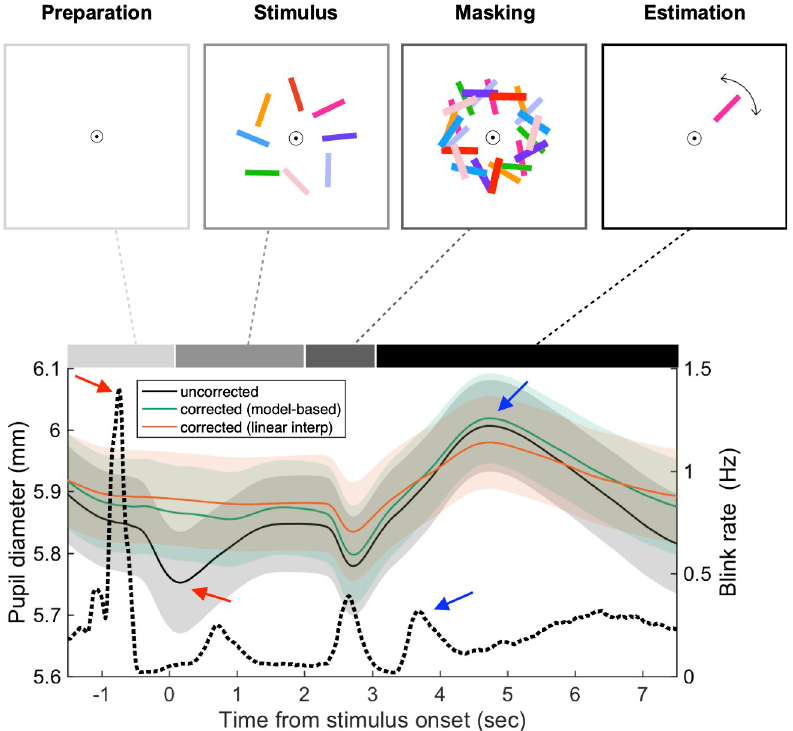
Fig 8. Temporal bias in blink patterns induces spurious distortion of pupil time course in the delayed orientation estimation task. Pupil (solid line) and blink rate (dotted line) time course during the delayed orientation estimation task. Since BPR induces pupillary constriction, the pupil-size time courses corrected by the model-based method (green) and the linear interpolation method (orange) were larger than pre-correction (black) overall, but note that the linear interpolation method decreased the time course when it was a hill (upper blue arrow). Note that subjects tend to blink more often at the preparation epoch, and it induces a spurious dip at stimulus onset (red arrows). It was flattened after applying both of the correction methods. Line and shade indicate the mean and SEM,